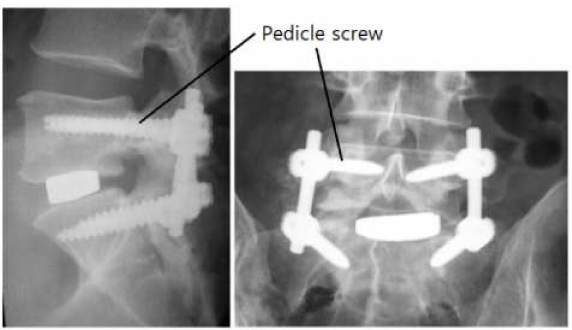
Figure 1. Radiographs after a lumbar interbody fusion surgery for degenerative disc